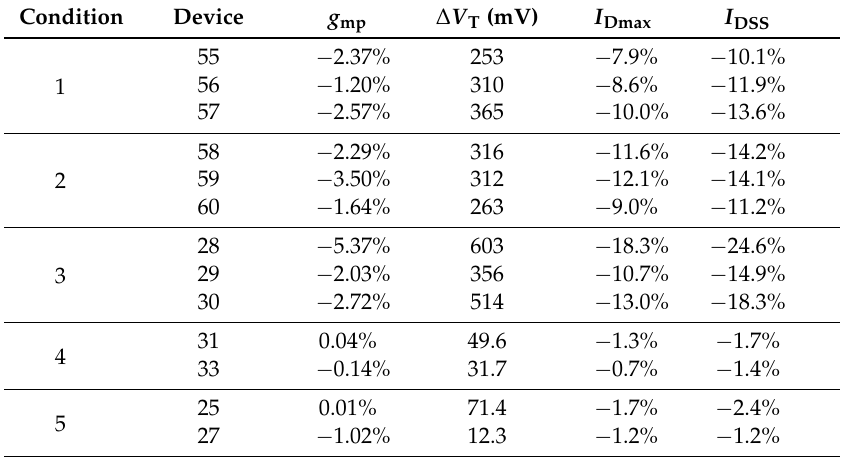
Table 2. Parameter changes by condition in 300-h test: g mp , V T , I Dmax , and I DSS